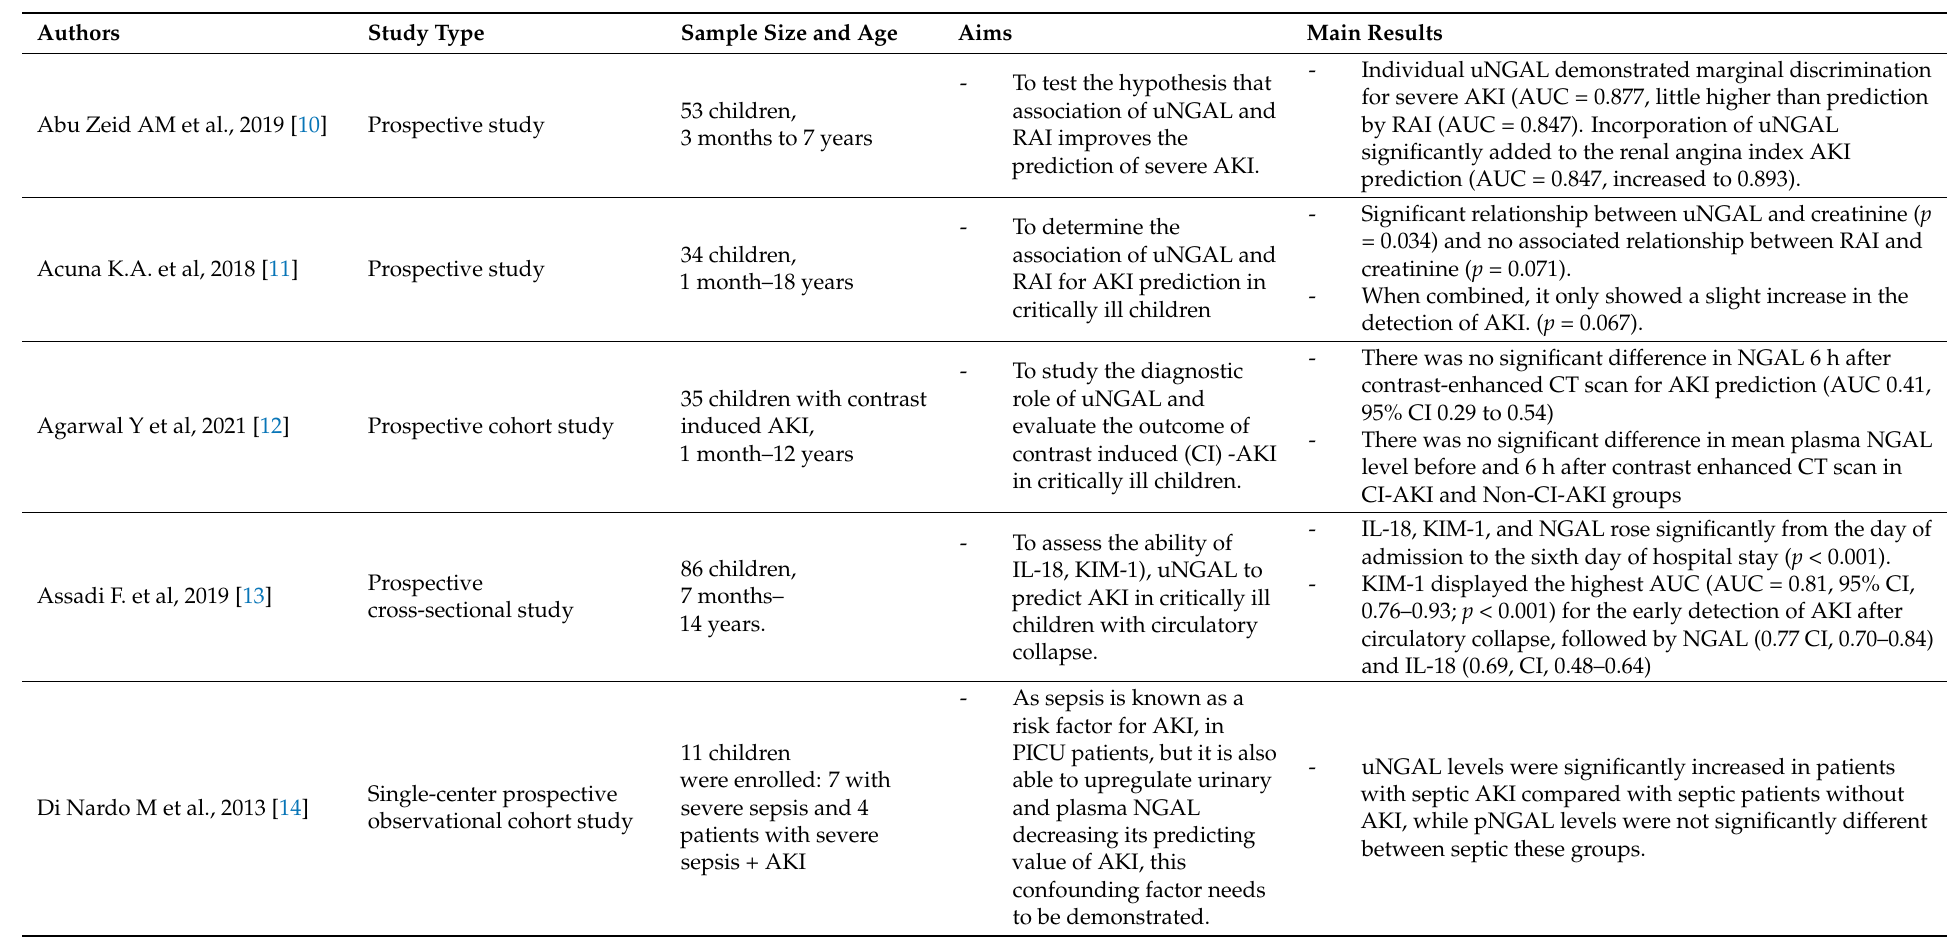
Table 4. Relevant studies depicting the role of urinary NGAL in